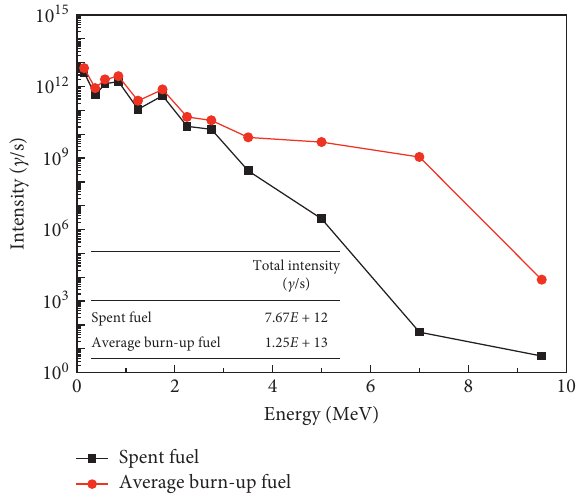
Figure 1: The source terms for the spent fuel and the average burn- up